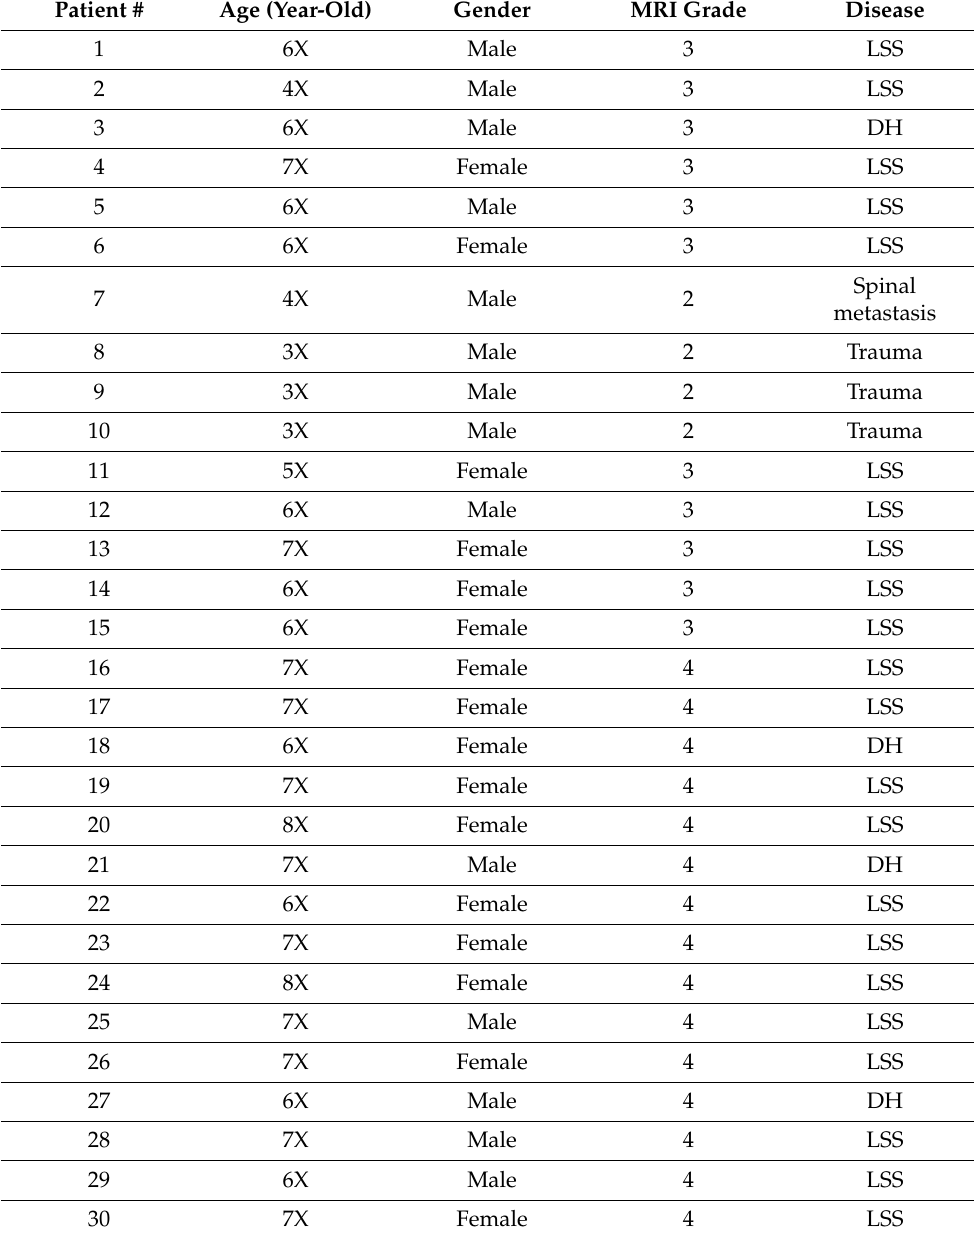
Table 1. Information on patients and intervertebral discs used in this